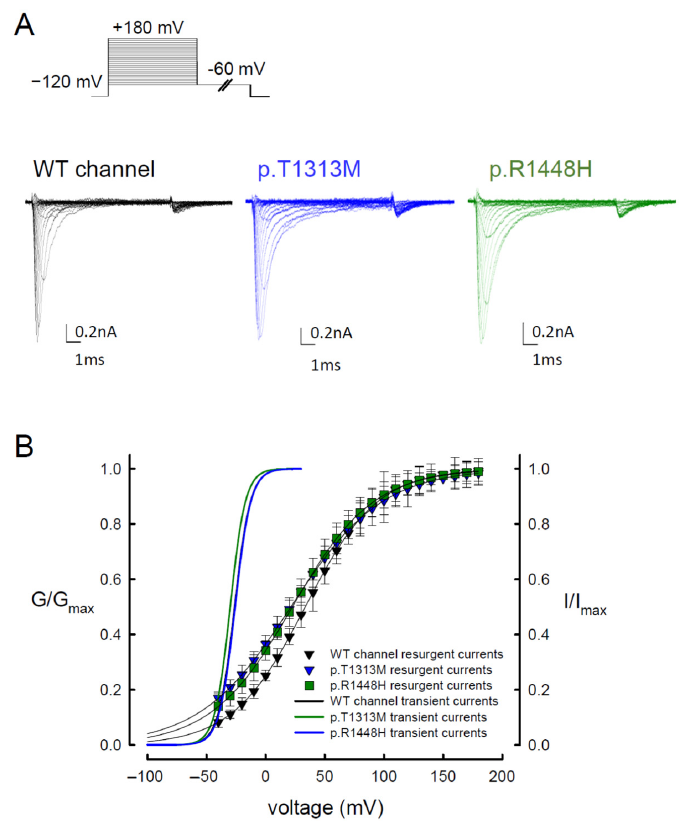
Figure 4. The Steady-state Activation Curves of Resurgent Na + Currents in the WT, p.T1313M, and p.R1448H Mutant Na v 1.4 Channels. ( A ) Sample sweeps were obtained with 100- μ M Na v β 4 peptide for the WT, p.T1313M, and p.R1448H mutant Na v 1.4 channels. The cell was held at − 120 mV for approximately 30 ms and then subjected to various depolarizing prepulses between − 60 and +180 mV for ~5 ms in 10-mV increments. Resurgent Na + currents were evoked by a repolarization pulse at − 60 mV for ~150 ms. ( B ) The steady-state activation curves of the transient (the fitting lines in Figure 1B) and resurgent Na+ currents in the WT, p.T1313M, and p.R1448H mutant Na v 1.4 channels are replotted for comparison. The resurgent Na + activation curve of the WT Na v 1.4 channel for each cell was obtained by fitting with Boltzmann functions, and the cumulative results for V h and k were +33.5 ± 1.44 mV and 30.62 ± 1.1 for ~10-ms prepulses, respectively ( n = 5). Those for p.T1313M mutant channels were +21.32 ± 3.11 mV and 38.59 ± 2.36 ( n = 5; p < 0.05), and those for p.R1448H mutant channels were +22.56 ± 1.74 mV and 34.37 ± 1.35 ( n = 5; p < 0.05).